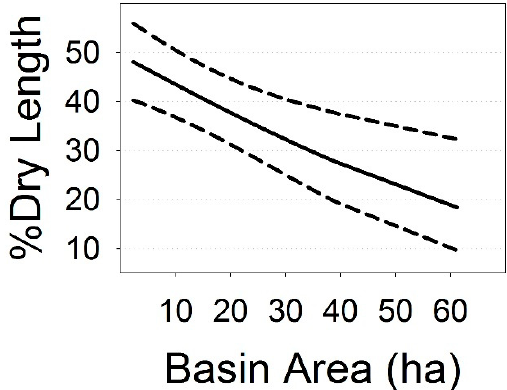
Figure 7. Modeled relationships between % dry stream-reach length and basin area. Solid line shows predicted values from simple linear mixed models, dashed lines show upper and lower 95% confidence intervals. Nested random effects for site, stream and reaches (repeated) are not shown.